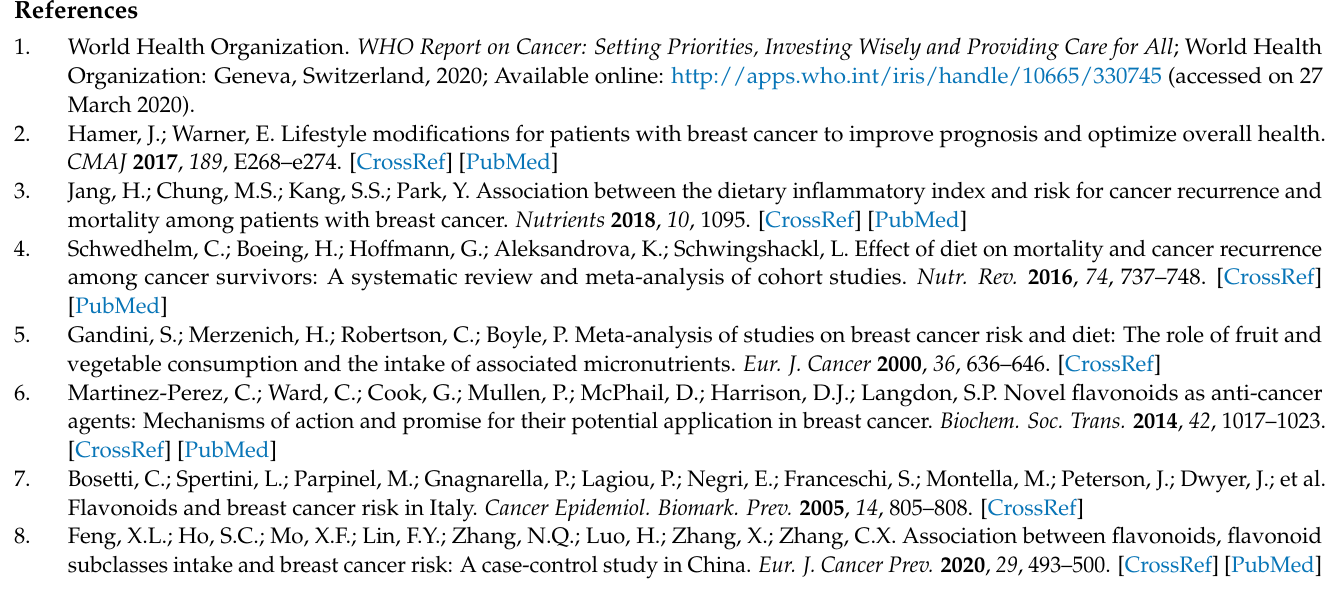
cancer, Supplement file 2: Table S1: Biochemical parameters in patients with and without cancer recurrence, Table S2: Association between dietary intake of flavonoids and cancer recurrence risk in all breast cancer patients, Table S3: Association between dietary intake of flavonoid-rich foods and cancer recurrence risk in breast cancer